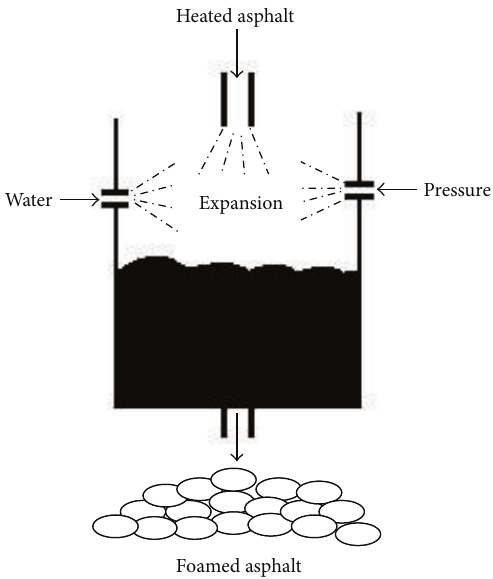
Figure 1: Schematic diagram of foaming